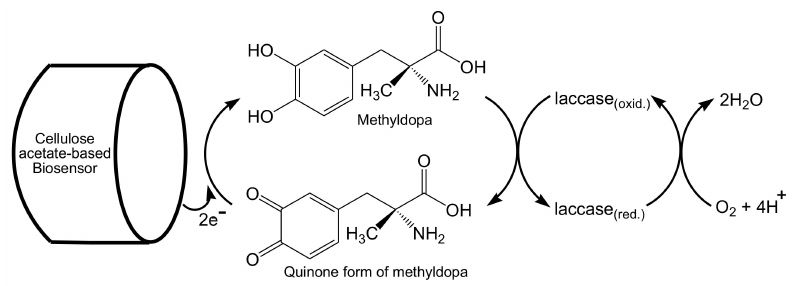
Figure 12. Schematic diagram representing the laccase-catalyzed oxidation of methyldopa with a sequent electrochemical reduction